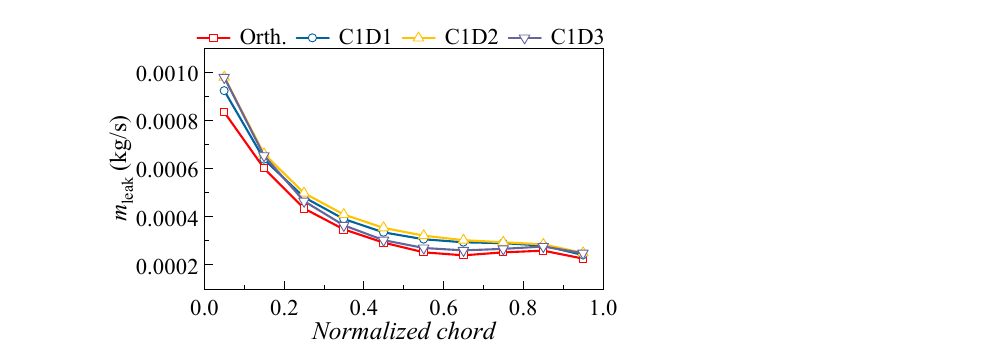
Figure 23. Comparison of the streamwise leakage mass flow rate under different dihedral angles ( φ = 0.46).